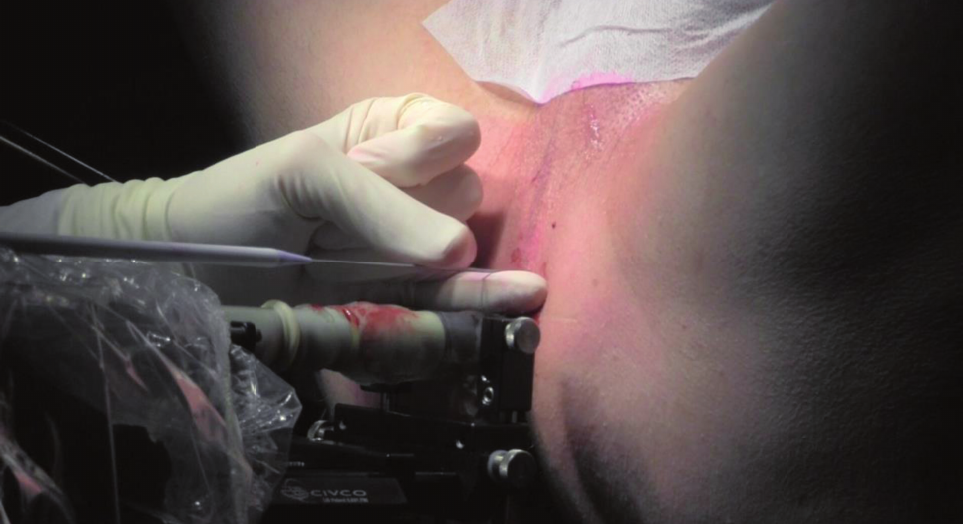
figure 5 - Transperineal insertion of the needle, with the dilatator (blue) and the sheath